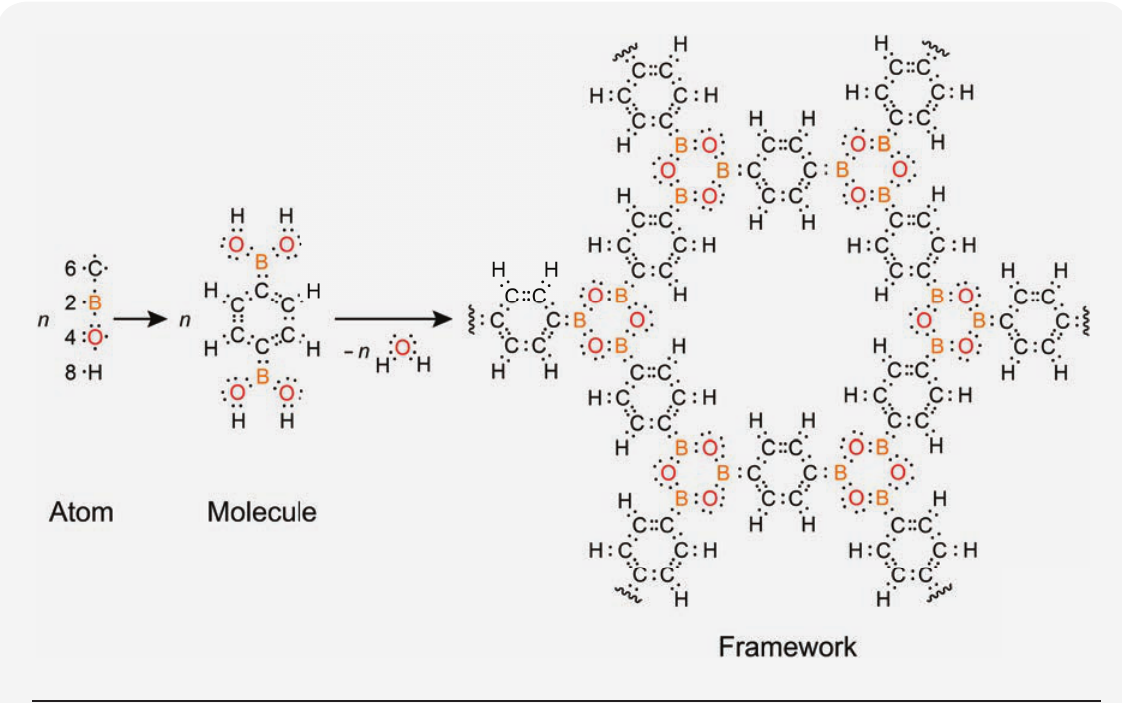
Fig. 12. The atom, the molecule, and the covalent organic framework. This progression indicates how the molecule fi xes atoms in specifi c geom- etry, connectivity, and spatial arrangement, and with reticular chemistry, the framework fi xes molecules in specifi c geometry, connectivity, spatial arrangement. However, unlike the molecule, the framework encompasses space into which matter can be further manipulated and